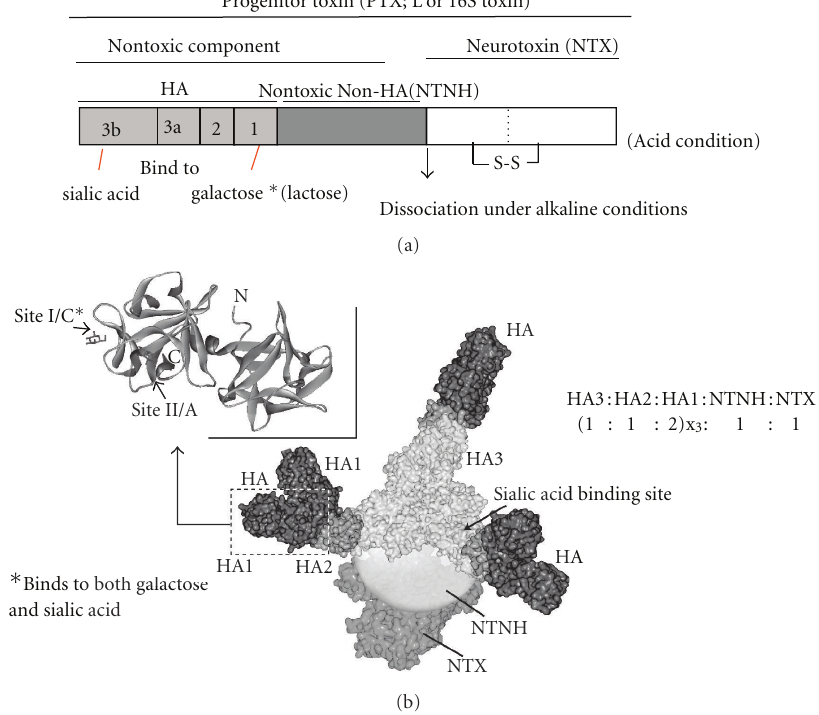
Figure 1: Progenitor L toxin structure. (a) Scheme indicating that (1) under alkaline conditions PTXs dissociate into an NTX and nontoxic components; (2) fully activated NTX is cleaved at a site in the N-terminus; (3) HA1 and HA3b bind galactose and sialic acid, respectively. (b) Predicted tertiary structure of type C and D L toxins and molar ratio of their (sub)components. Model is based on the structural data of Hasegawa et al. [8] and Nakamura et al. [7]. Three dimensional structure of HA1 and its binding sites for sugars are also shown. Both type A and C HA1 showed similar structures consisting of two β -trefoil domains conjugated by an α -helix. Two sugar-binding sites (I and II) on C-terminal β -trefoil domain are predicted and A-HA1 and C-HA1 binds to galactose via sites II and I, respectively. In the case of type C, HA1 also bound to sialic acid via site I